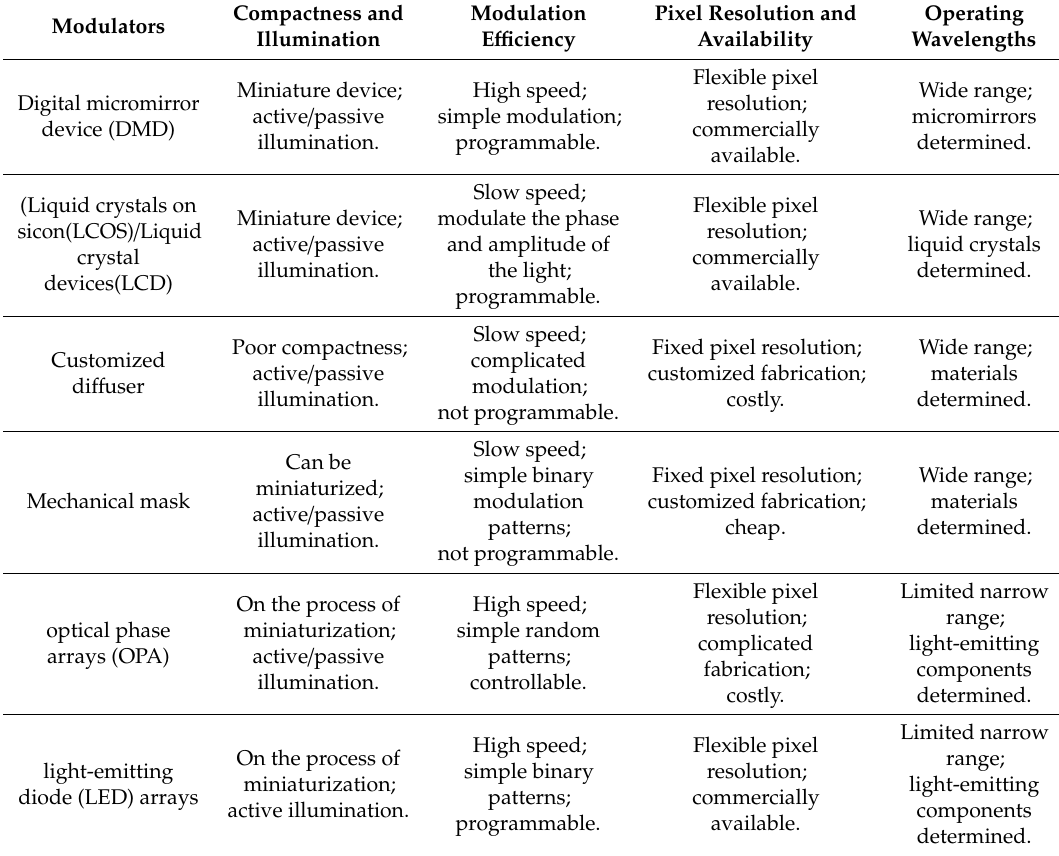
Table 1. A summarized table of various modulators applied in single-pixel imaging